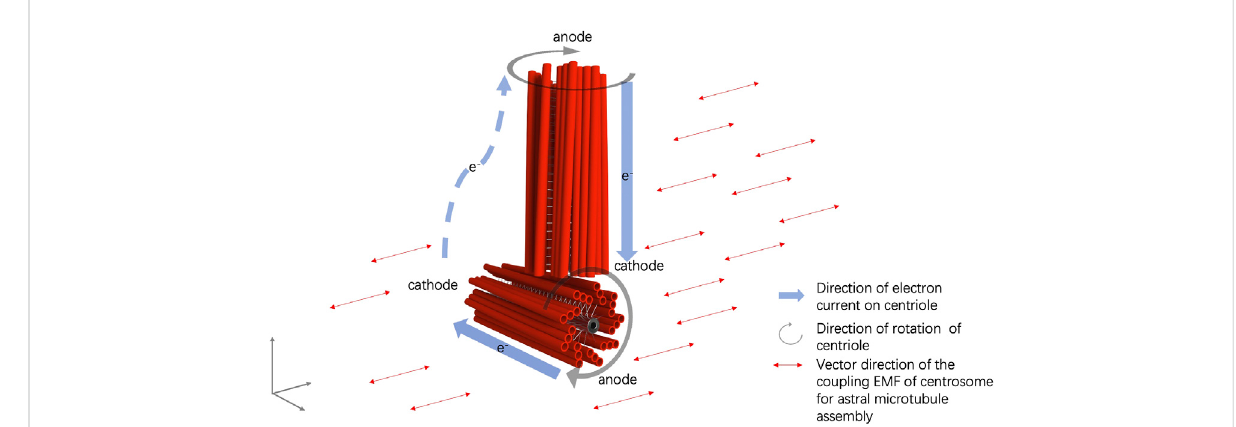
FIGURE 1 Illustration of the electromagnetic fi eld and electric currents within and around the centrosome.